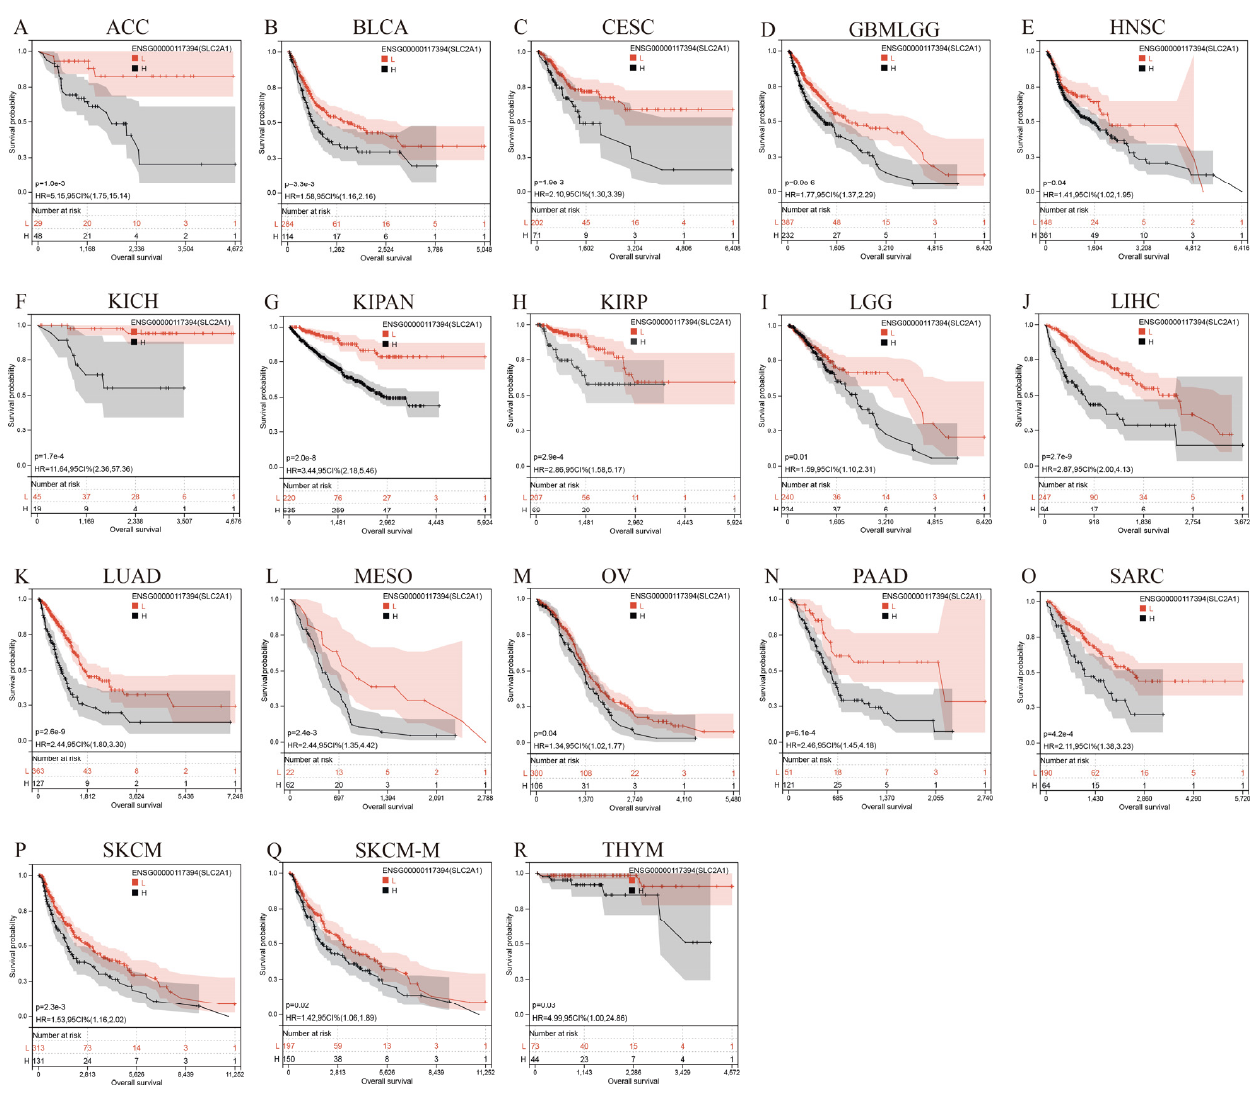
Figure 7. Pan-cancer Kaplan–Meier overall survival of SLC2A1 in indicated tumor types from TCGA database ( A – R ).